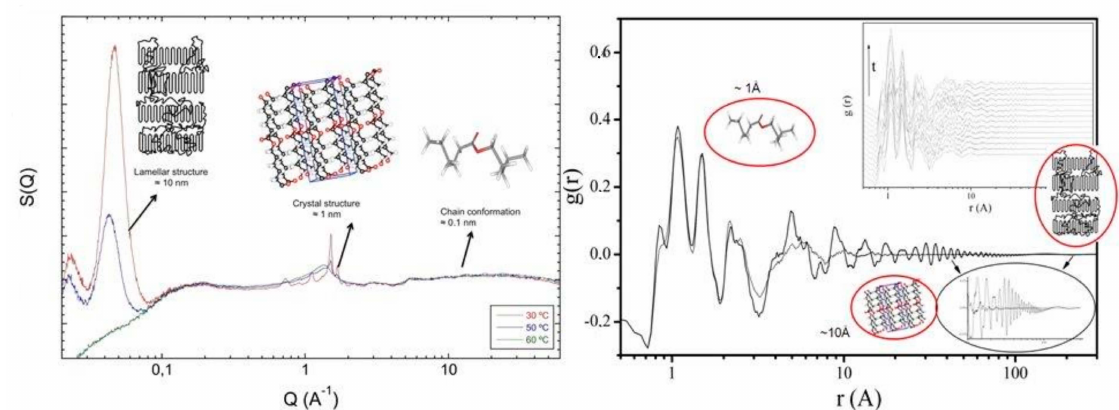
Figure 14. Experimentally observed structure factor (left) and radial distribution function (right) as obtained from a simultaneous small and wide angle neutron scattering experiment in NIMROD. The di ff erent length scales associated with the di ff erent regions of the functions is highlighted. The inset in the right figure indicates the time evolution of the radial distribution function with temperature.